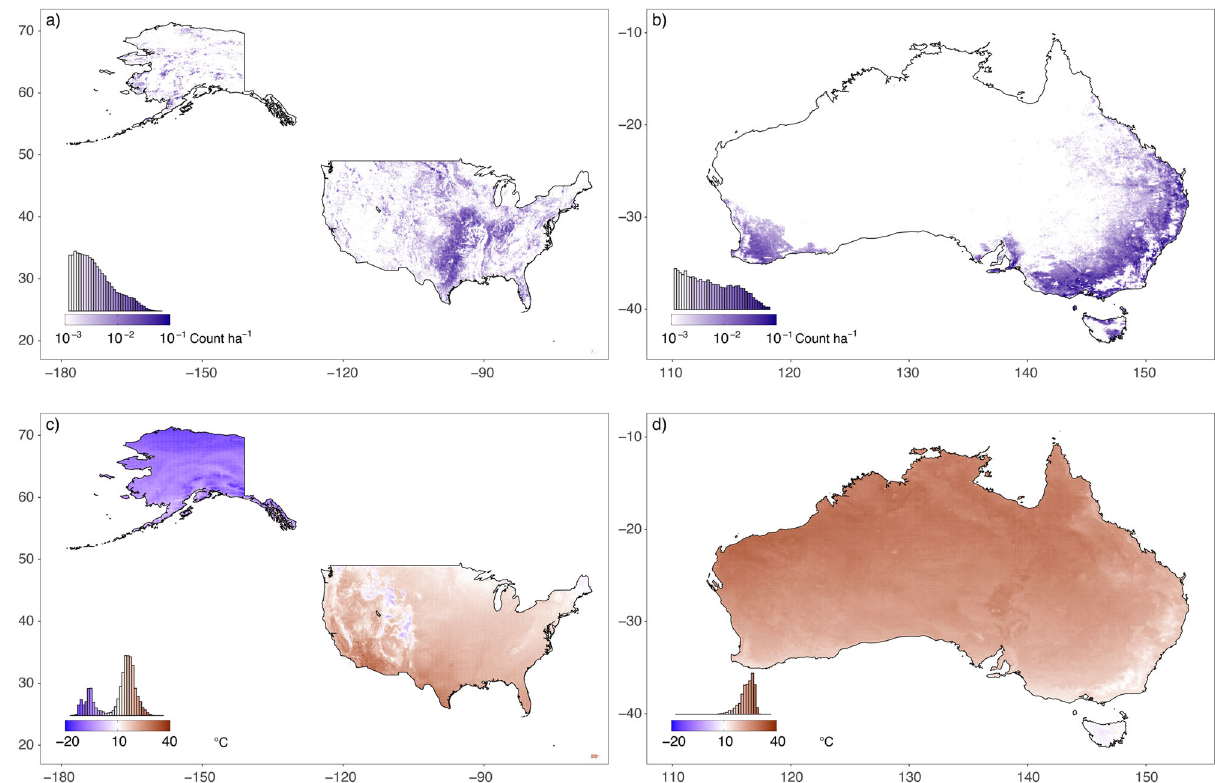
Fig. 1 Covariates (at 5 arcmin resolution) used to parametrise our model on methane emissions from agricultural ponds. a Densities of agricultural ponds in the United States (2.56 millions) from Moore et al. 13 . b Densities of agricultural ponds in Australia (1.76 millions) from AusDams in Malerba et al. 6 . c Annual median temperatures in the United States. d Annual median temperatures in Australia. All temperatures are calculated using 10 years of weekly data from MODIS Terra Land Surface in Wan et al. 32